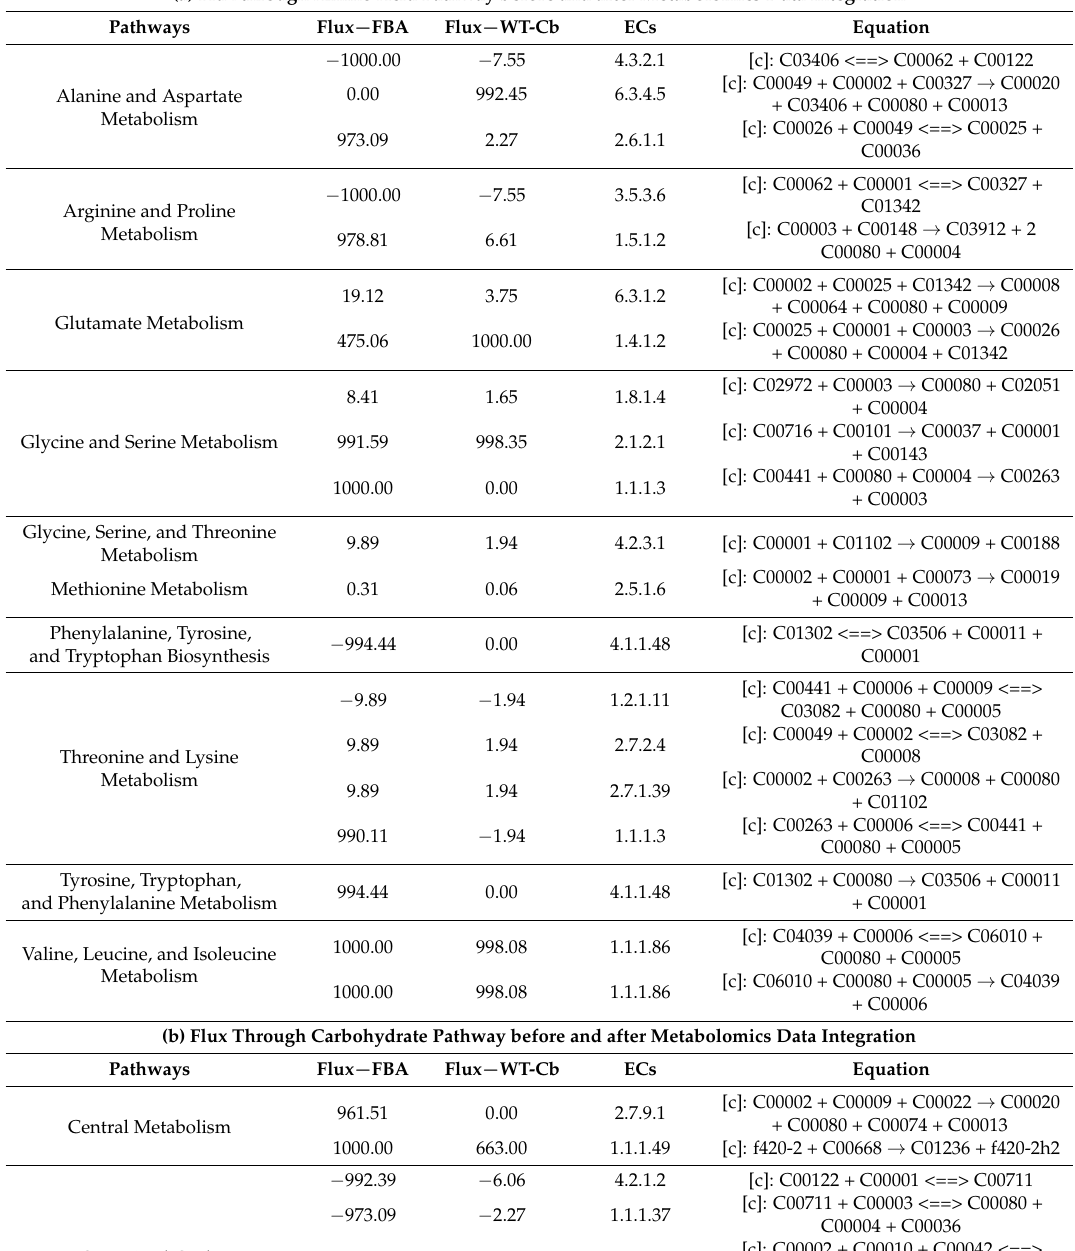
Table 6. Computational predictions of fluxes through pathways for ( a ) amino acid metabolism and ( b ) carbohydrate metabolism using flux balance analysis (Flux-FBA) and after integrating metabolomic data for growth on cellobiose